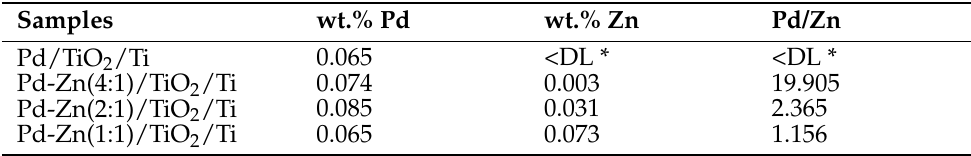
Table 2. ICP-MS analysis of the amounts of Pd and Zn in the wire catalysts.